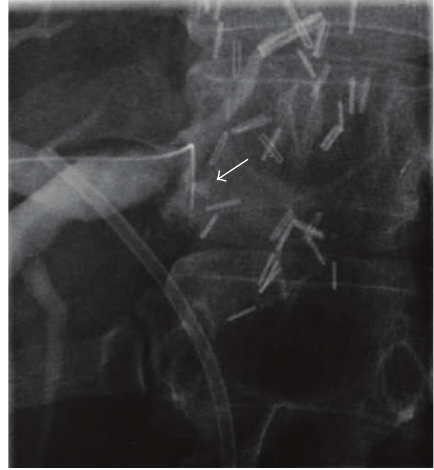
Figure 2: Cholangiogram showing the guide wire (arrow) during unsuccessful attempts to cross the anastomotic obstruction.